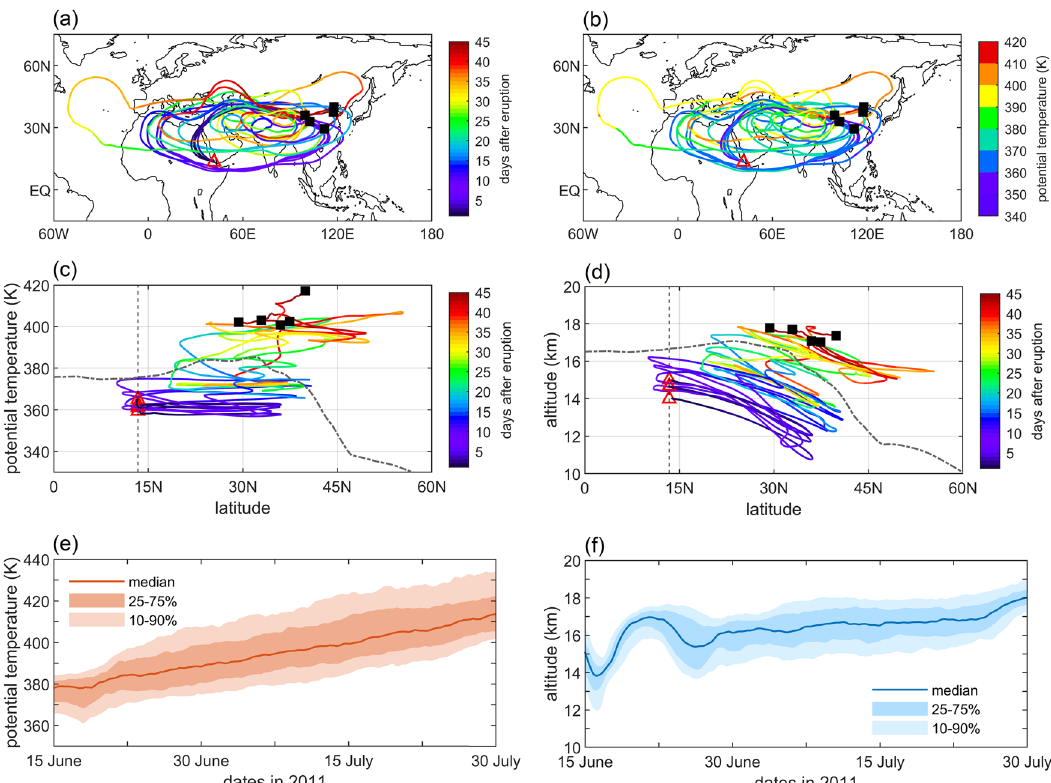
Fig. 5 Evolution of the attributes of the forward trajectories. Selected forward trajectories colored by a the days after 12 June 2011 and b the potential temperature (PT, unit: K) of the air parcels. c The latitude versus PT cross-sections of the forward trajectories and d the latitude versus altitude cross-sections colored by days after 12 June 2011. The open red triangles and the fi lled black squares indicate the starting and end locations of the selected air parcels, respectively. The vertical gray dashed line indicates the latitude of the Nabro volcano. The gray dot- dashed lines in ( c ) and ( d ) show the PT and altitude of the tropopause, respectively. The evolution of the altitude ( e ) and PT ( f ) of the air parcels elevated from the upper troposphere to the lower stratosphere within the ASMA. The solid line indicates the median value. The dark shading indicates the range of the 25th – 75th percentiles, and the light shading indicates the range of the 10th – 90th